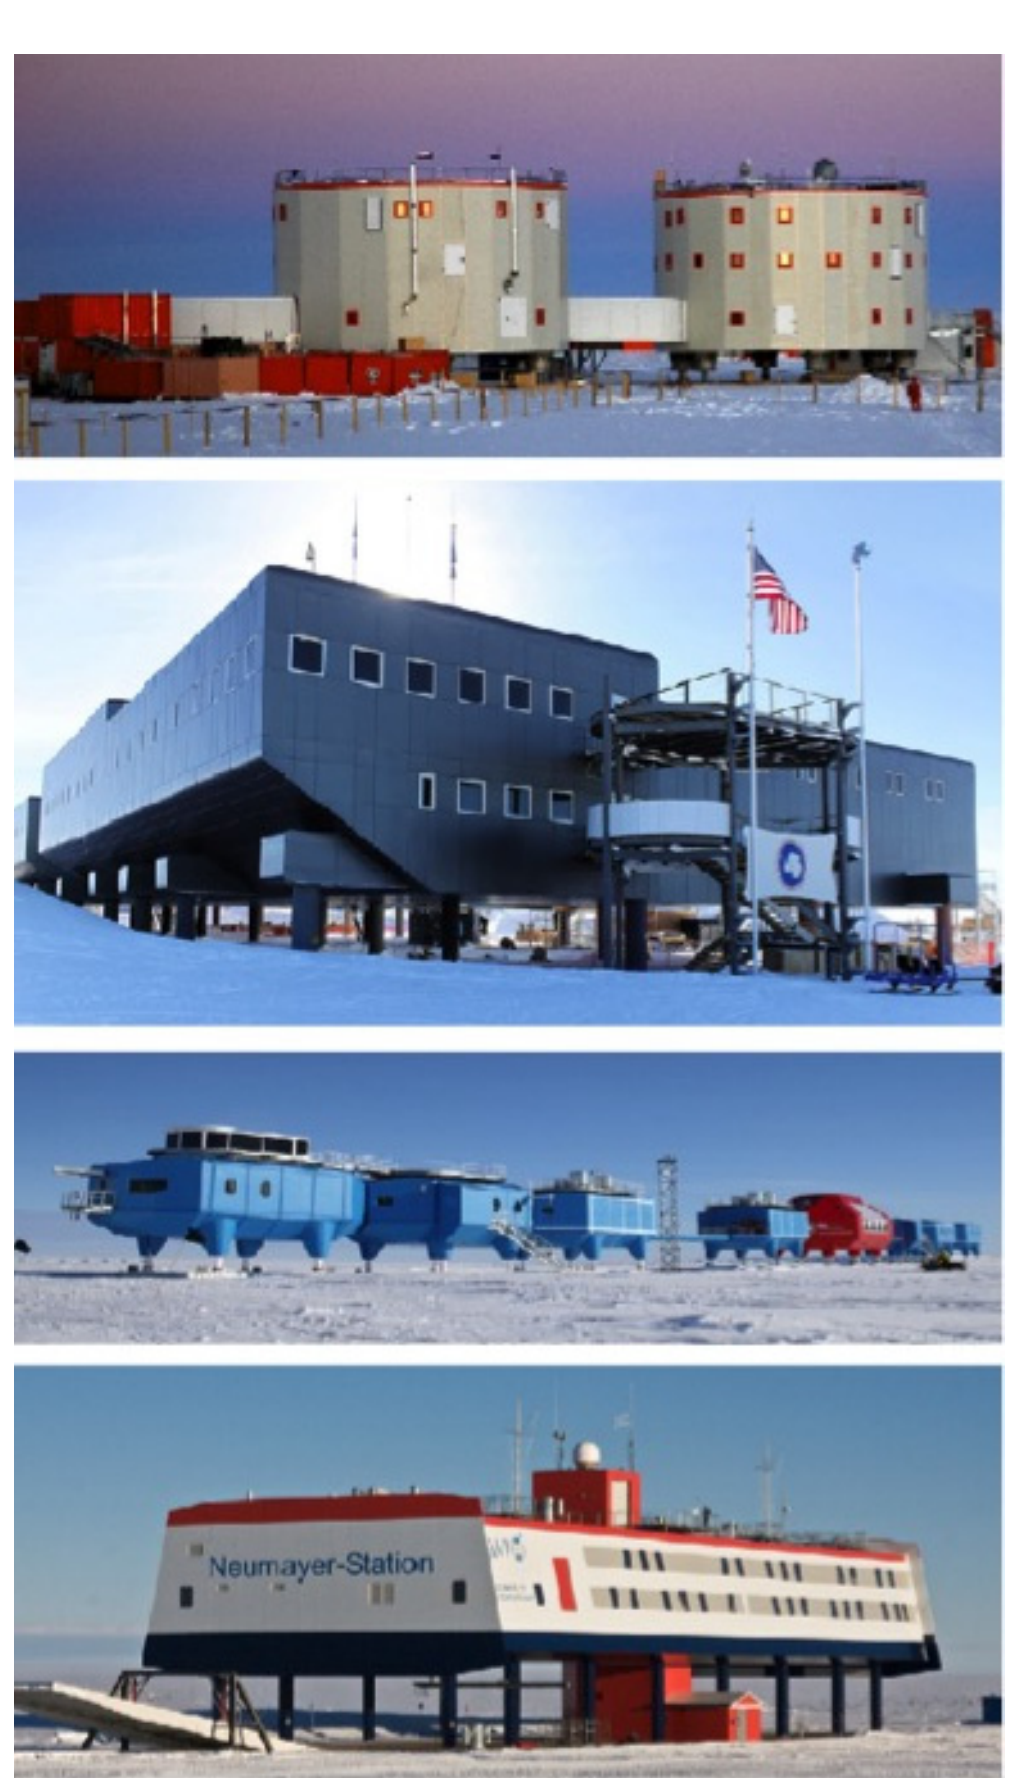
Figure 3. Four examples of modern stations erected on iced layered surface, over special legs or pillars. From top to bottom: Concordia sta- tion (Italy - France), new Amundsen-Scott South Pole station (USA), Halley VI (Great Britain), Neumayer-Station III